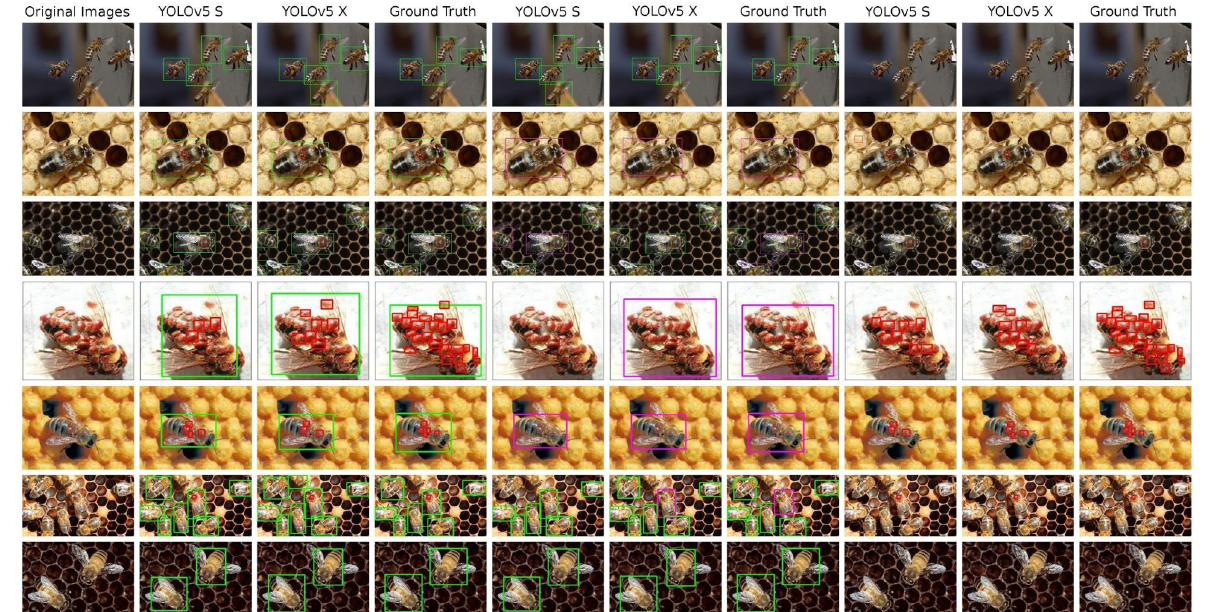
Figure 5. An overview of the detections performed on test images by the YOLO models, complemented by ground truth annotated images. 1st column: original image; 2nd–4th column—model trained in bees and V.-mites detection; 5th–7th column: models trained in healthy and ill bees detection; 8th–10th column: models trained in V.-mite detection only.